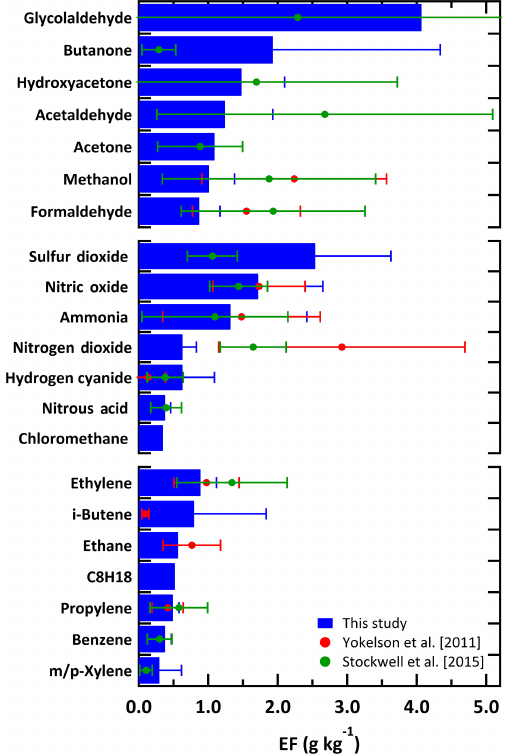
Figure 4. The emission factors (gkg − 1 ) and ± 1 standard deviation for the most abundant OVOCs, NMHCs, and S- or N-containing compounds emitted from crop residue burns. The crop residue fires from other studies (Yokelson et al., 2011; Stockwell et al., 2015) are shown in red and